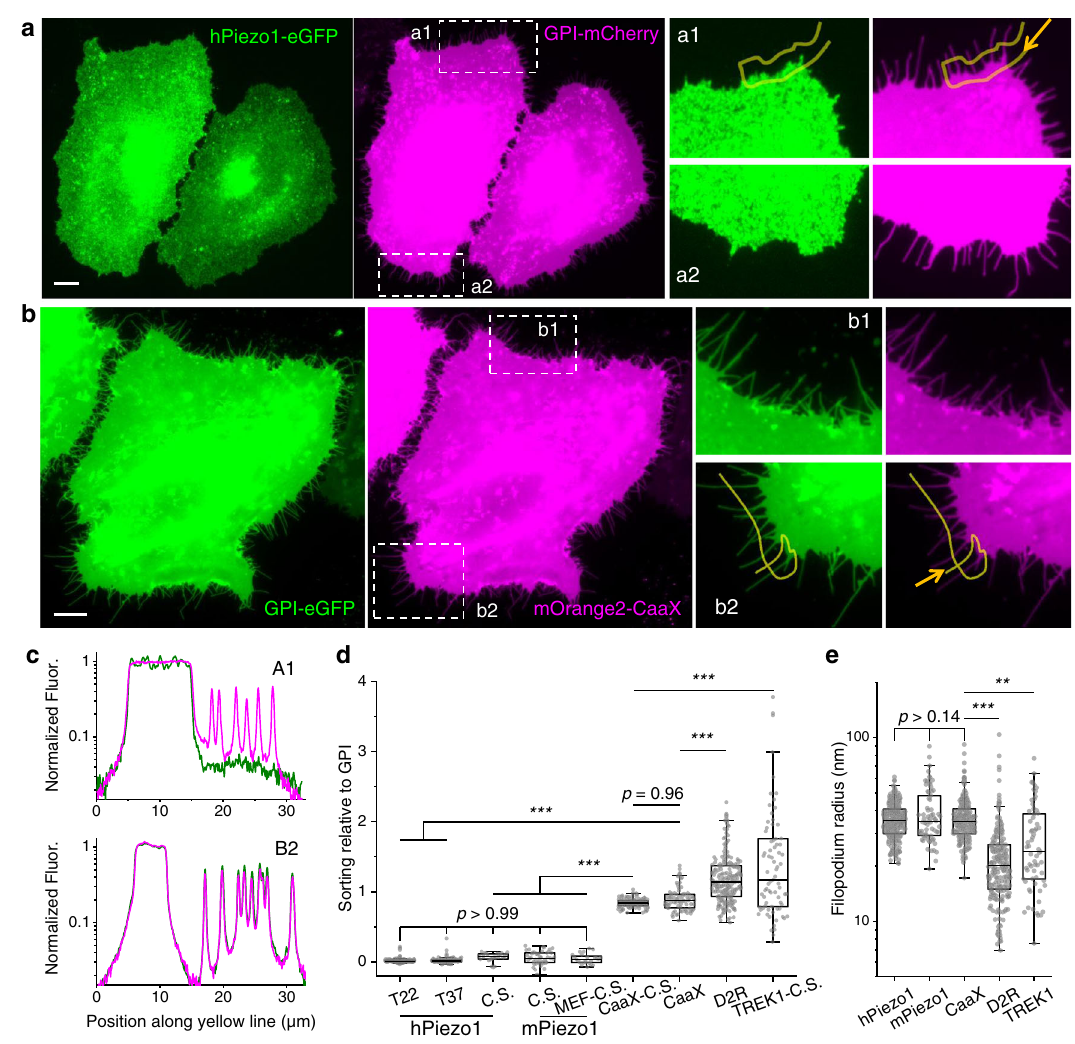
Fig. 1 | Piezo1 isdepleted from fi lopodia.a Fluorescenceimages of HeLa cellsco- expressing hPiezo1-eGFP (left) and GPI-mCherry (middle). The two boxed regions (a1, a2) are zoomed-in on the right. Images are contrast-adjusted to show the dim fi lopodia, see Fig. S1a for images under regular contrast. b Fluorescence images of HeLa cells co-expressing GPI-eGFP (left) and mOrange2-CaaX (middle). The two boxed regions (b1, b2) are zoomed-in on the right. All scale bars are 10 µ m. c Fluorescence intensity pro fi les along the marked yellow lines in a1 (up) and b2 (down). Green: hPiezo1 (up) and GPI (down). Magenta: GPI (up) and CaaX (down). Each fl uorescence trace was normalized to the mean intensity on the corre- sponding fl at cell body. d Filopodia sorting of eGFP fused hPiezo1 (T22: at 22°C, n.f.=129,n.c.=12;T37:at37°C:n.f.=113,n.c.=8),CaaX(n.f.=87,n.c.=9),andD2R (n.f.=222, n.c.=15) relative to GPI-mCherry. C.S.: color swap, indicating the mole- cule of interest was fused with red or orange fl uorescent proteins (tdTomato for